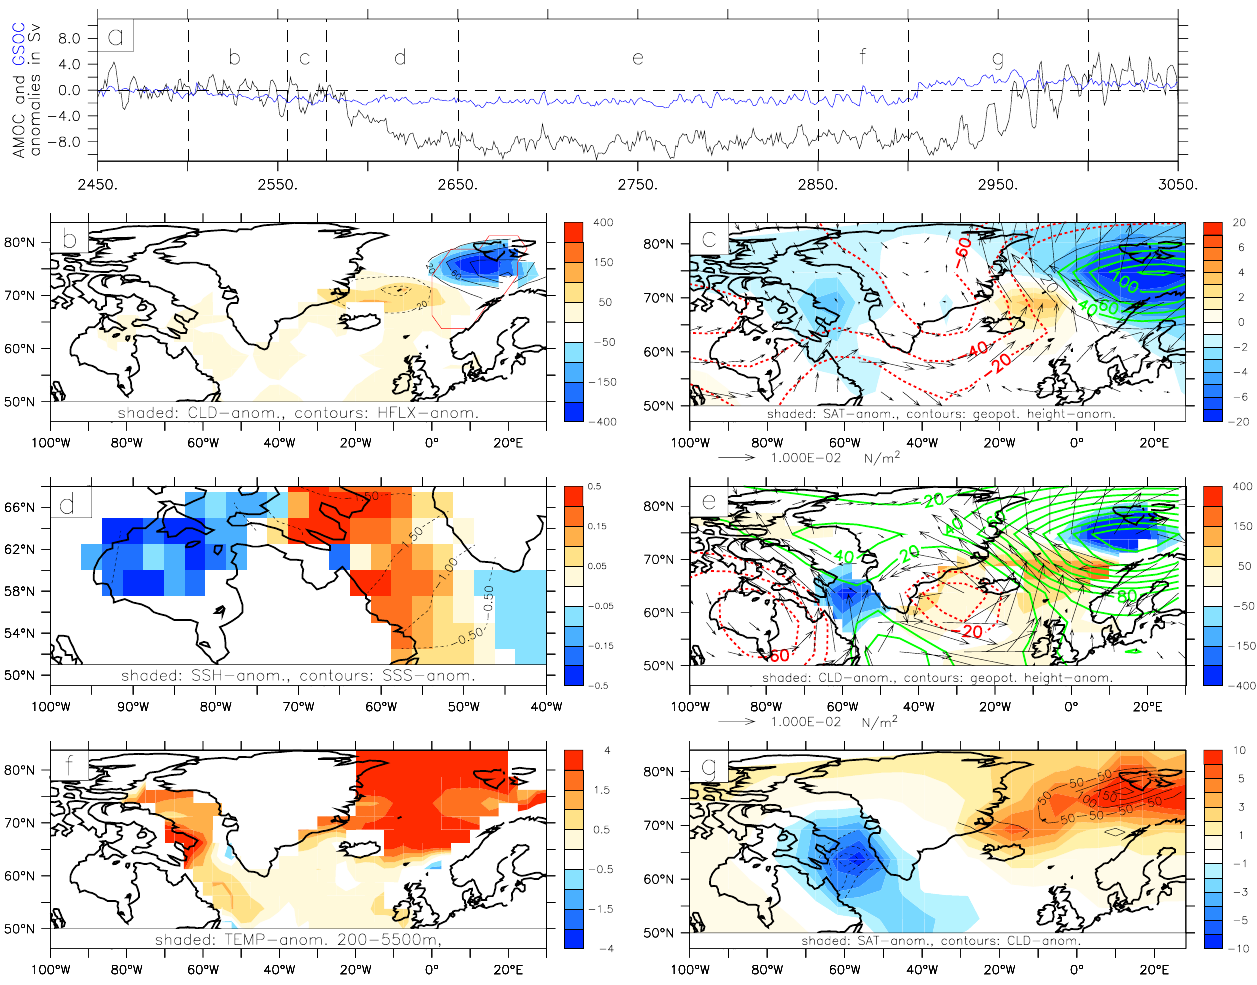
Fig. 3. (a) Anomalies of AMOC (black) and GSOC (blue) in Sv for the OBL22.4 run for the timeframe 2450–3050 (see also Fig. 2c,h). Dashed vertical lines denote averaging intervals for panels b-g of this figure. (b) Anomalies in convective layer depth (CLD) in m (shaded) and surface heat flux (HFLX) in W/m 2 (contours). A positive HFLX anomaly is associated with a lower-than-normal heat loss of the surface ocean to the atmosphere. The red line indicates the mean GIN Sea sinking region in the model. (c) Anomalies of surface air temperature (SAT) in K (shaded), 800mbar geopotential height in m 2 /s 2 (contours) and surface wind stress in N/m 2 (arrows). (d) Anomalies of sea surface height in m (shaded) and sea surface salinity in psu (contours). (e) Anomalies in CLD in m (shaded), 800mbar geopotential height in m 2 /s 2 (contours) and surface wind stress in N/m 2 (arrows). (f) Anomalies of oceanic temperature in K averaged over 200–5500m. (g) SAT anomalies in K (shaded) and CLD anomalies in m (contours). All anomalies in panels b-g are calculated against a strong AMOC state (years: 2400–2450) and averaged over the interval indicated by the respective letter in panel